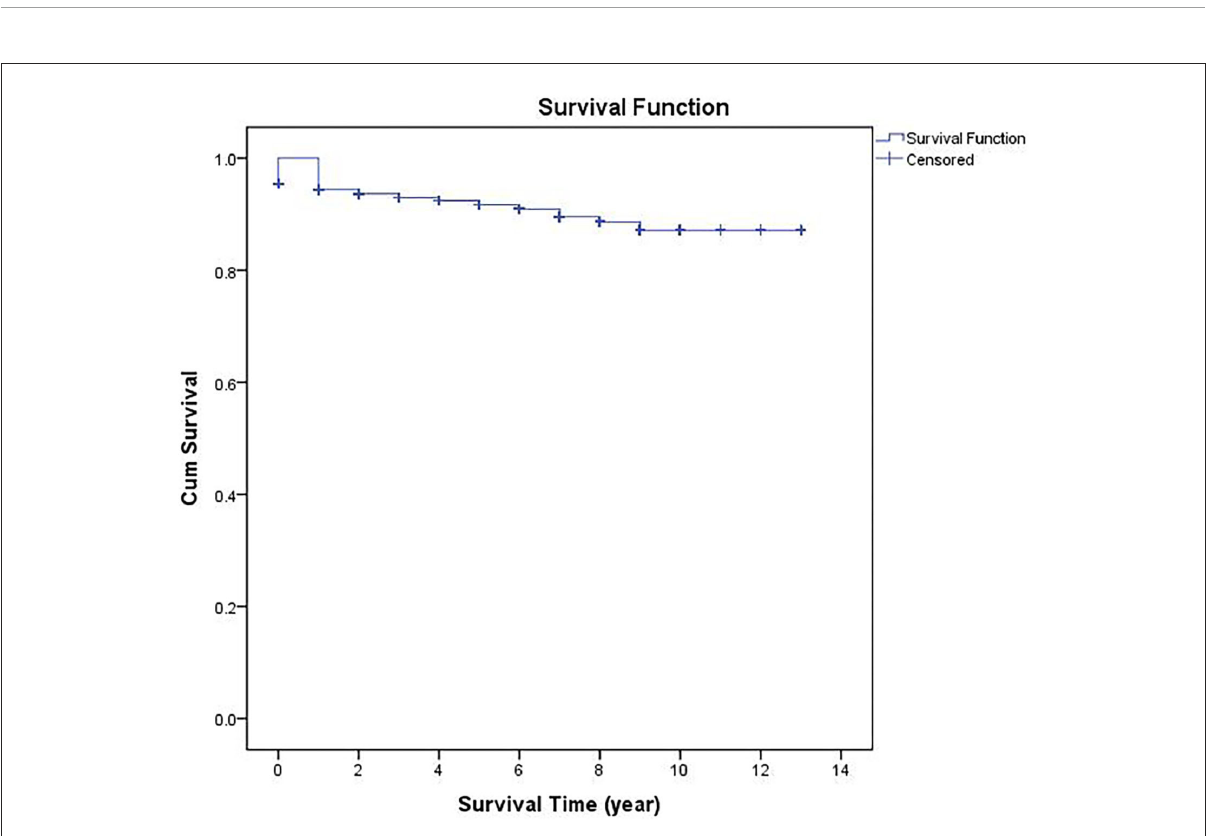
FIGURE1 Survival curve for PLHIV from 2005 to 2018 in Nanjing,